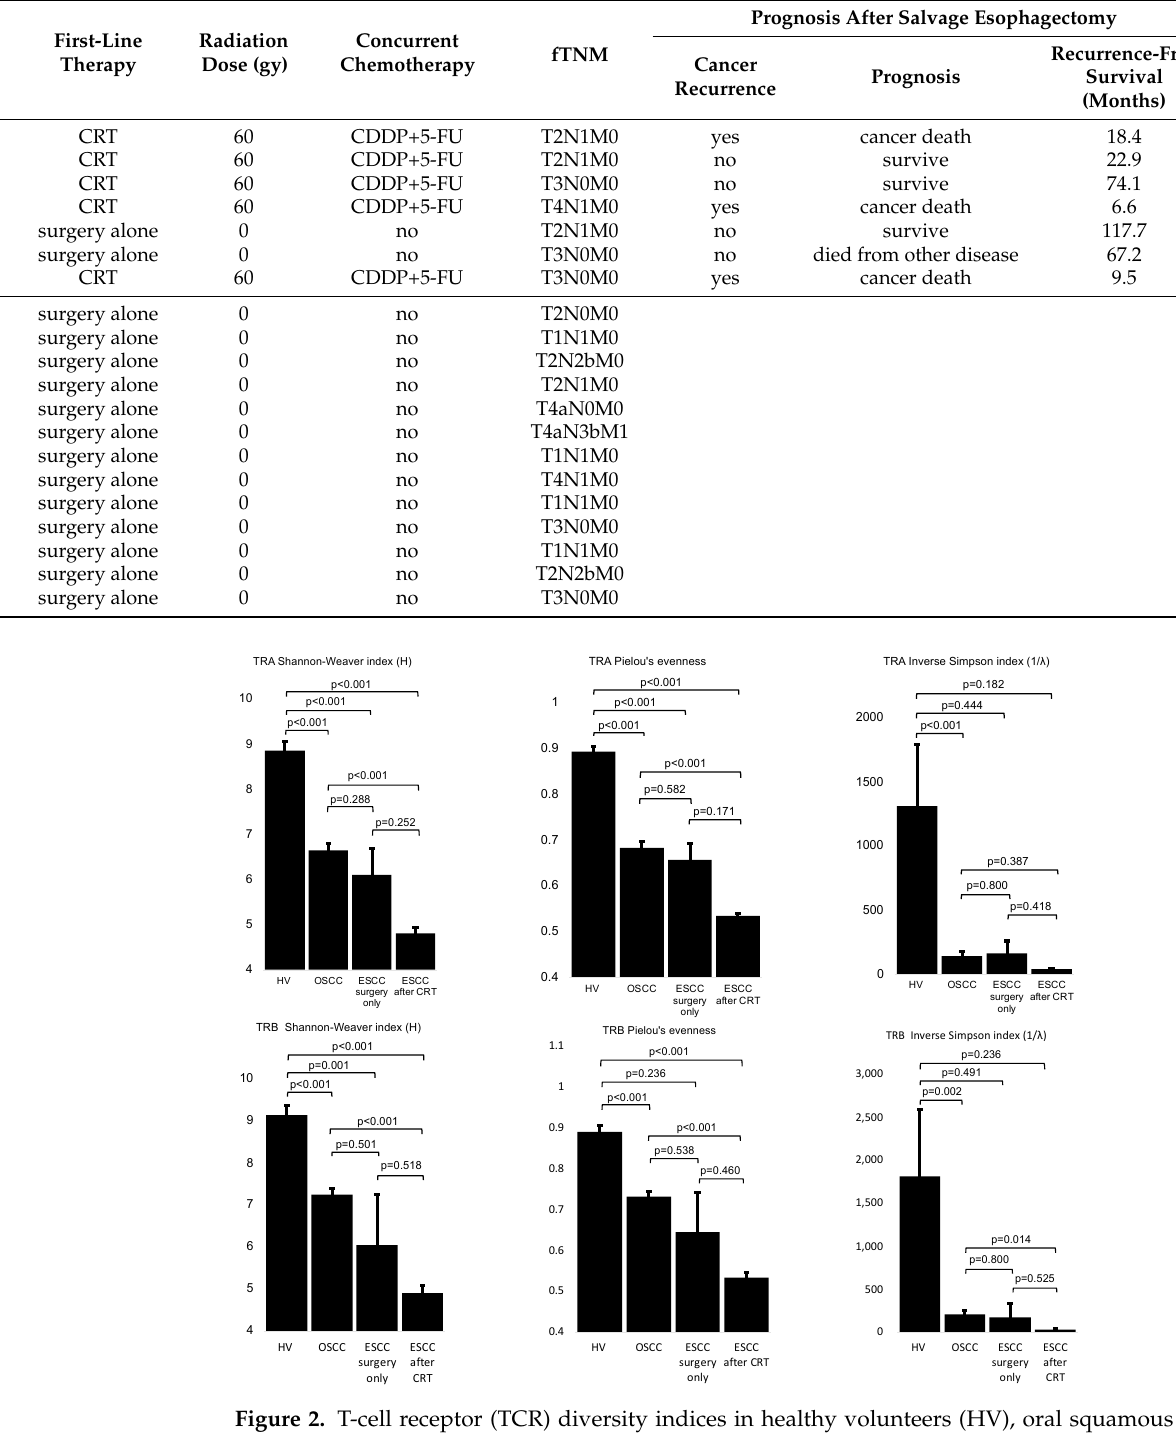
Figure 2. T-cell receptor (TCR) diversity indices in healthy volunteers (HV), oral squamous cell carcinoma (OSCC) treated by surgery alone, and esophageal squamous cell carcinoma (ESCC) with or without preceding chemoradiation therapy. Each bar indicates a mean value of each TCR repertoire index with an error bar as the standard error.